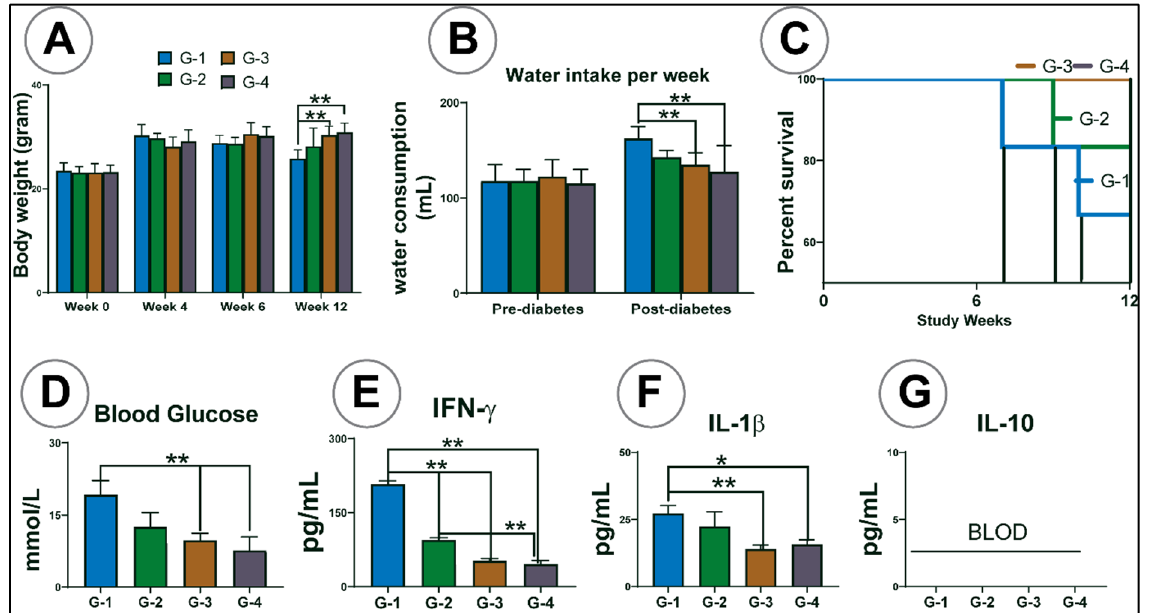
Figure 6. ( A ) Mice body weight at different weeks, ( B ) water consumption rate, ( C ) survival rate, ( D ) blood glucose measurement at the end of the experiment, ( E ) concentration of pro-inflammatory cytokines in plasma, interferon-γ, ( F ) concentration of pro-inflammatory cytokines, interleukin-1β, and ( G ) concentration of anti-inflammatory cytokines, interleukin-10. G-1 = group one as a diabetes control mice fed with the high-fat diet, G-2 = mice treated with free PB, G-3 = mice treated with PB-SA = F1 microcapsules, G = 4 mice treated with PB-LCA-SA = F2 microcapsules. BLOD = below the limit of detection. Data are presented as mean ± SD. p < 0.05*, p < 0.01**.